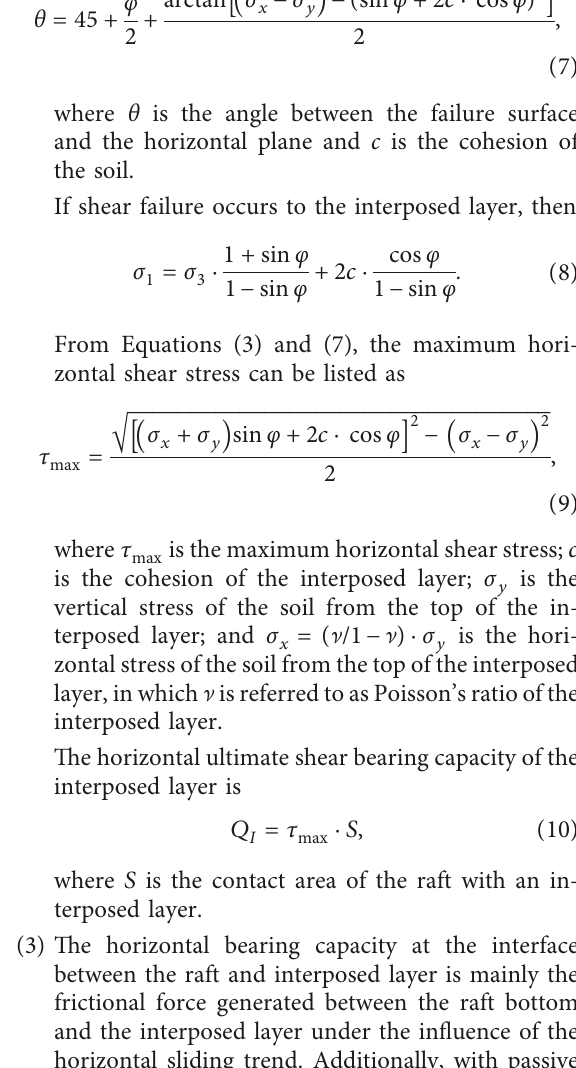
Figure 14: Vector diagram of soil particles in the displacement